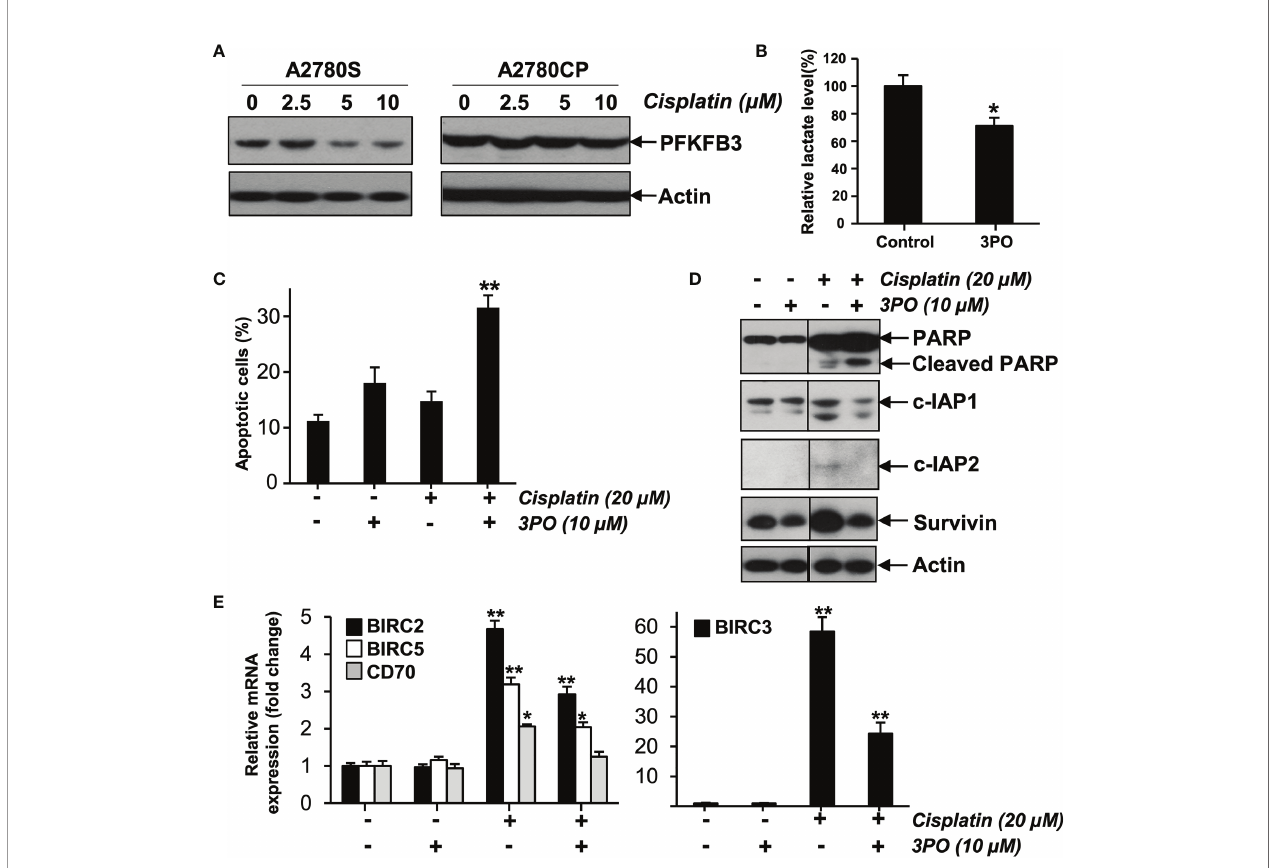
FIGURE 2 | PFKFB3 regulates chemoresistance in ovarian cancer. (A) Protein levels of PFKFB3 in A2780S and A2780CP cells treated with cisplatin (0, 2.5, 5 and 10 µM) for 48 h, determined by immunoblotting. (B) Relative lactate production level of A2780CP cells treated with 3PO (0, 10 µM), determined by Lactate Colorimetric Assay Kit II. (C) A2780CP cells treated with 3PO (0 and 10 µM) and cisplatin (0 and 20 µM) for 48 h, cell apoptosis was detected by Annexin V- FLUOS staining. (D) Protein expression of PARP, cleaved PARP, c-IAP1, c-IAP2 and survivin in A2780CP cells treated with 3PO (0 and 10 µM) and cisplatin (0 and 20 µM) for 48 h, determined by immunoblotting. (E) Bar chart of BIRC2, BIRC3, BIRC5 and CD70 genes mRNA expression in A2780CP cells treated with 3PO (0 and 10 µM) and cisplatin (0 and 20 µM) for 48 h, determined by the human apoptosis RT 2 pro fi ler PCR array. (n = 3; *p < 0.05; **p <